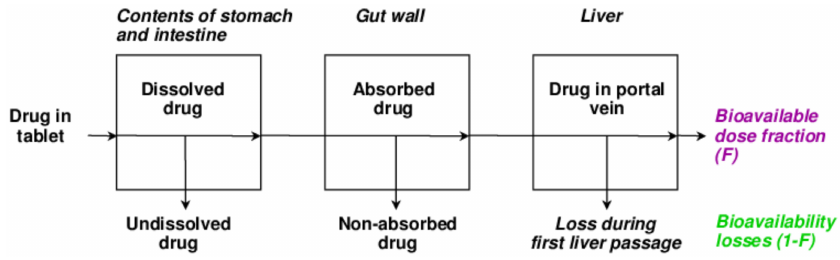
Figure 15. Schematic of factors accountable for the reduction in